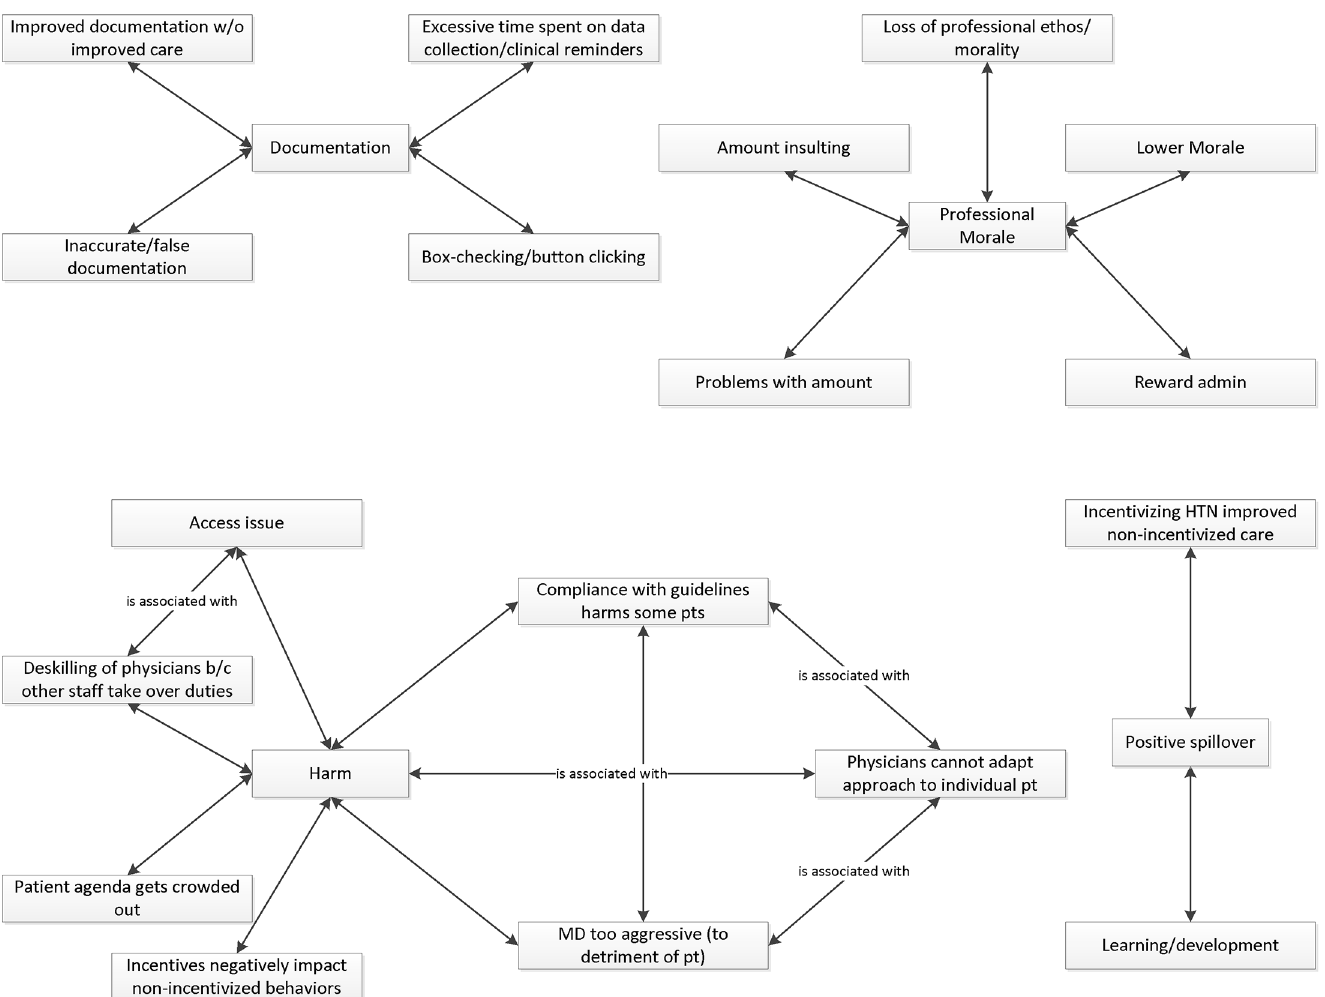
Fig 2. Network diagram of codes and organizing